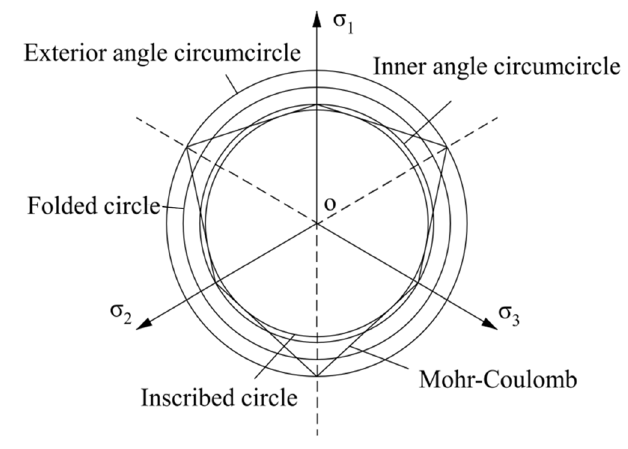
Figure 4. M-C and D-P in slant plane.